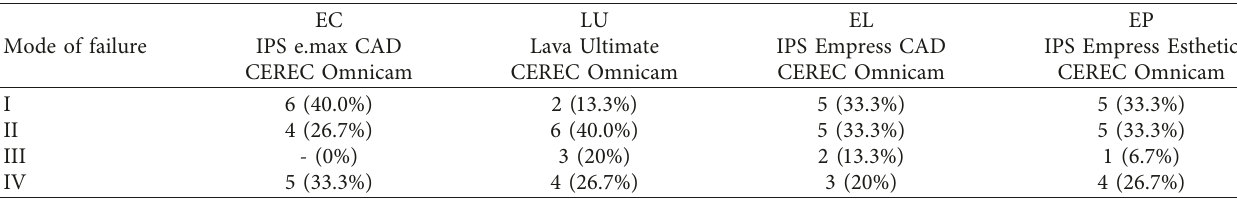
Table 4: Fracture modes of restored specimens according to Burke [17].